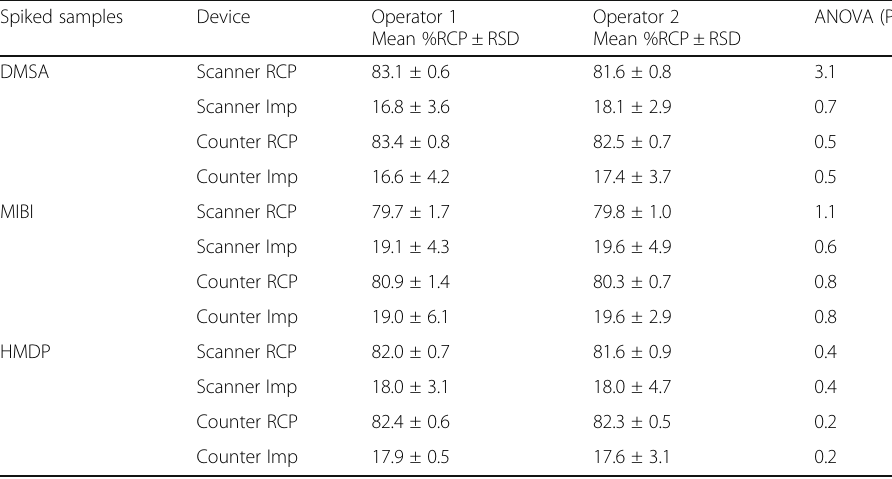
Table 3 Intermediate Precision results: Different Operators ( n = 5, acceptance criteria P ≥ 0.05) Spiked samples